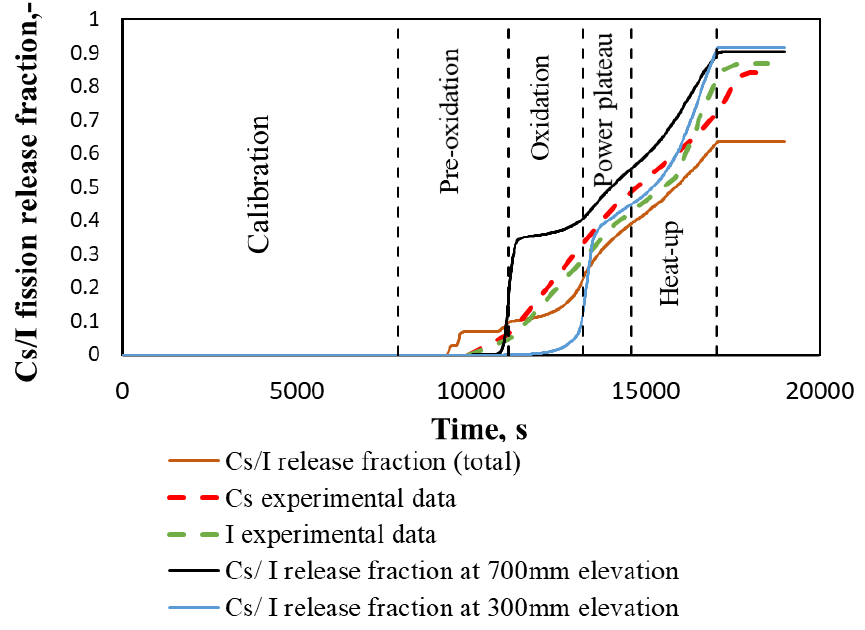
Figure 9. Comparison of calculated Cs/I release fraction with experimental data.